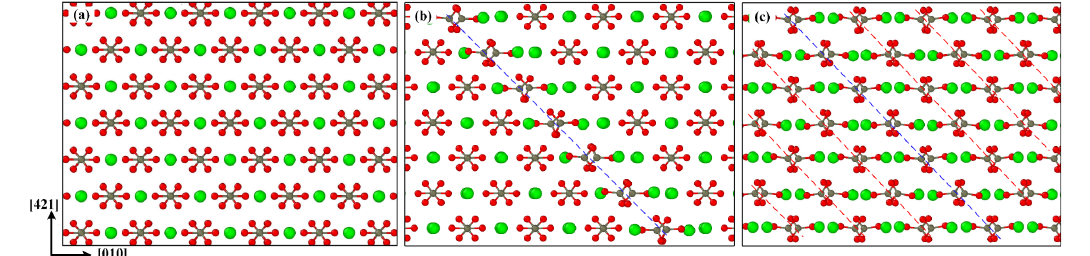
Figure 7. Dislocation initiation and development: ( a ) initial perfect calcite structure, ( b ) a dislocation line formed at the rapid stress reduction stage, ( c ) a new ordered phase formed by dislocation development.